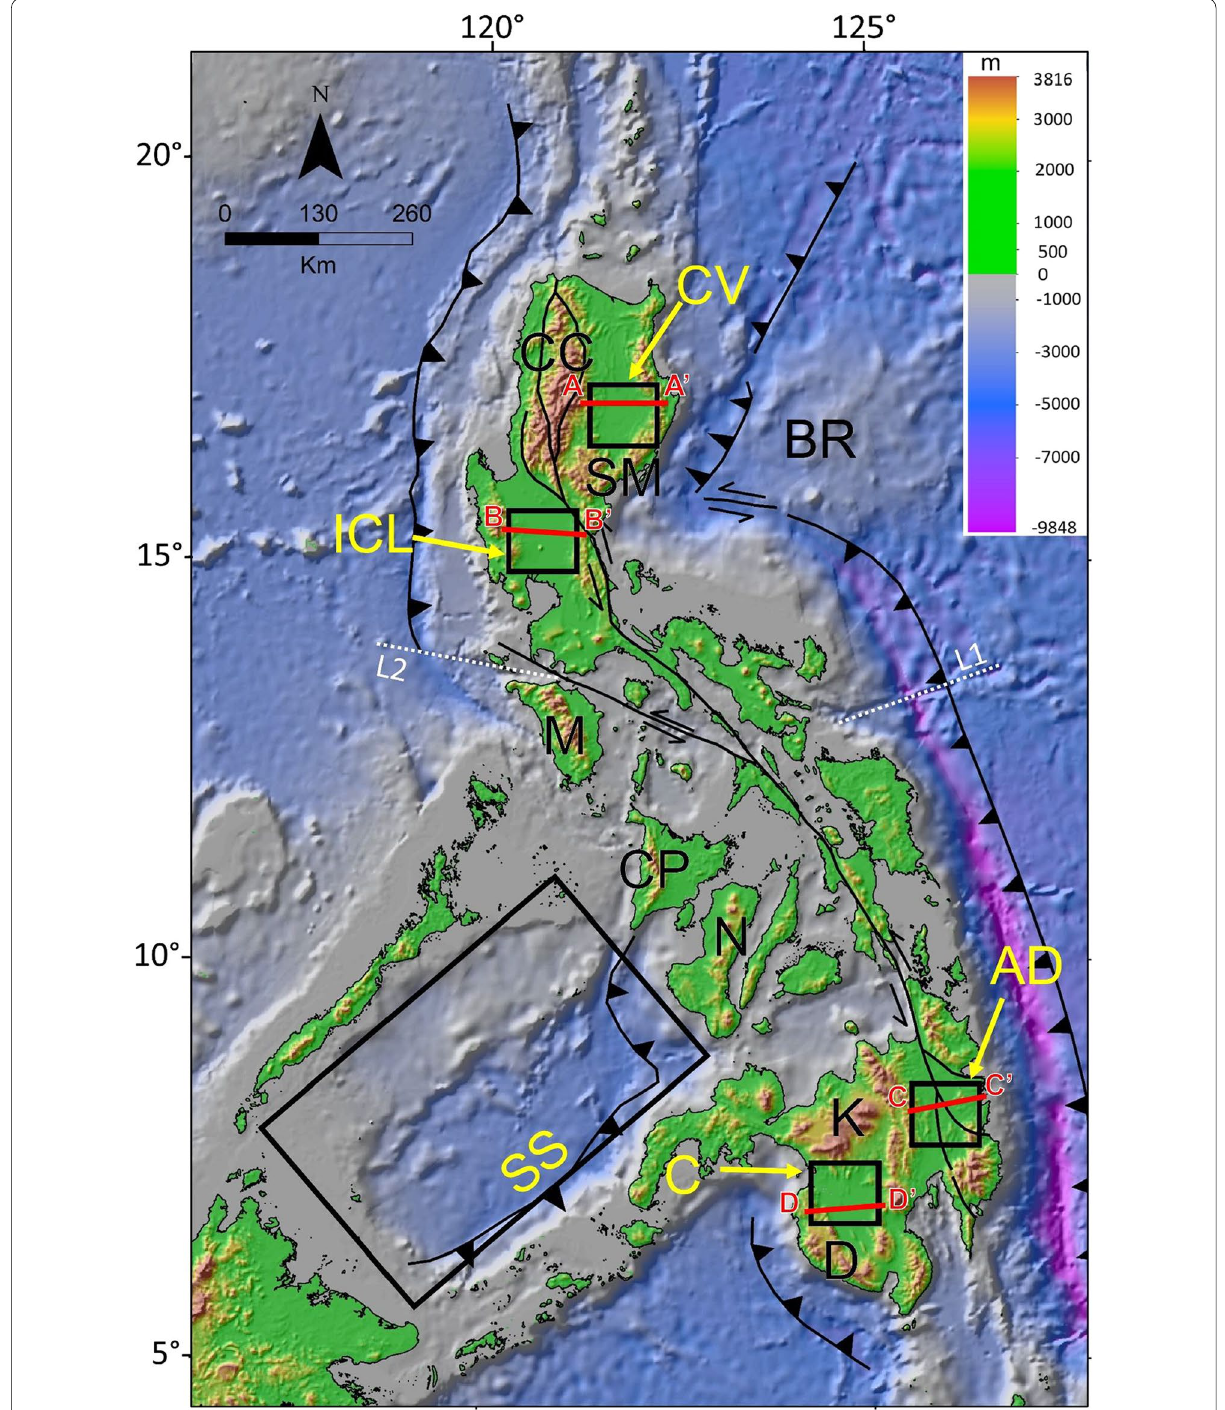
Fig. 2 Topographic and bathymetric map of the Philippines modified from GEBCO (2020) (https:// downl oad. gebco. net) showing major structural and tectonic features. The trenches surrounding the Philippine archipelago correlate with the deep bathymetric features. The topographic highs of Luzon Island include Central Cordillera (CC), Sierra Madre (SM), and Zambales Range (ZR). Katanglad Mountains (KM) and Daguma Range (DR) are the prominent elevated areas in Mindanao Island. Black-line boxes represent the locations of the specific areas where the 2-D radially averaged power spectrum technique (SS) and 3-D gravity inversion (CV, ICL, C, AD) were applied. CV Cagayan Valley Basin, ICL Ilocos-Central Luzon Basin, = = AD Agusan-Davao Basin, C Cotabato Basin, SS Sulu Sea, BR Benham Rise. A–A ′ , B–B ′ , C–C ′ , D–D ′ are section lines representing the geological = = = = cross sections presented in Figs. 10 and